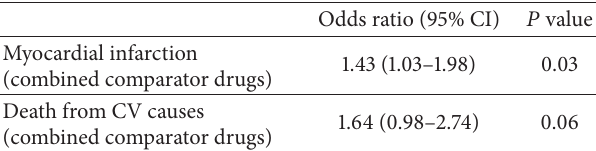
Table 4: Adverse outcomes [6].